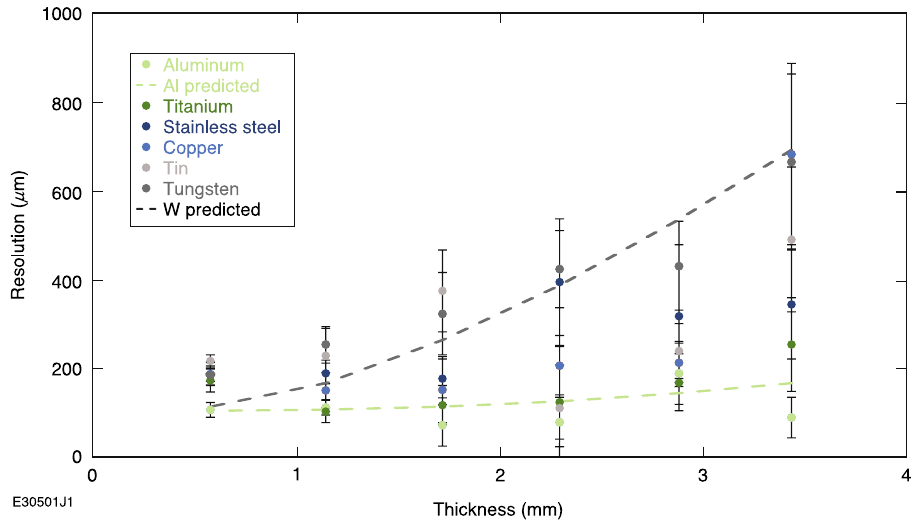
Figure 5. Resolution of contact radiography test object versus target thickness. Theoretical predictions based on Eqs. (3)–(6) for the tungsten and aluminum objects are included to guide the eye at the extremes of contact radiography test object Z